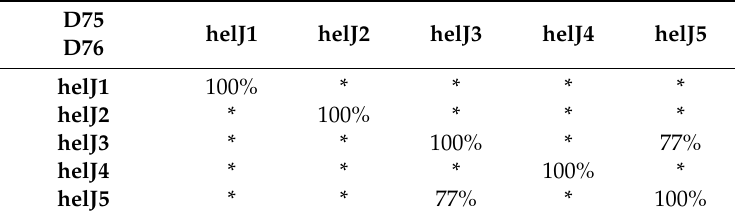
Table 2. Similarity between the nucleotide sequences of genes helJ1 , helJ2 , helJ3 , helJ4 , and helJ5 in L. helveticus D75 and D76.